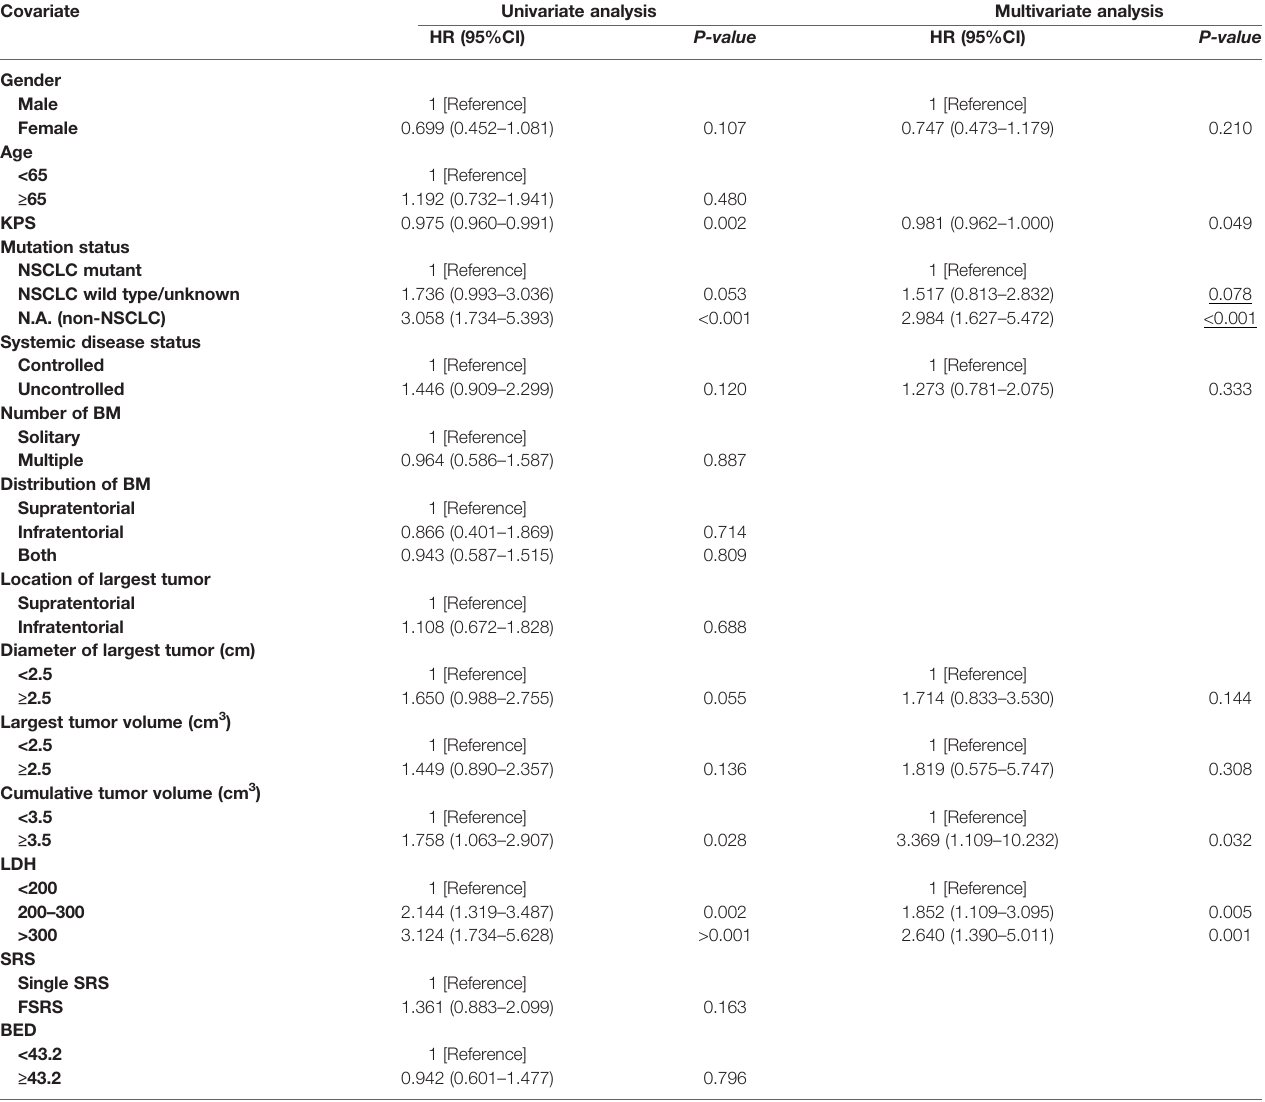
TABLE 2 | Univariate and multivariate analysis for overall survival in BM patients treated by SRS in the training